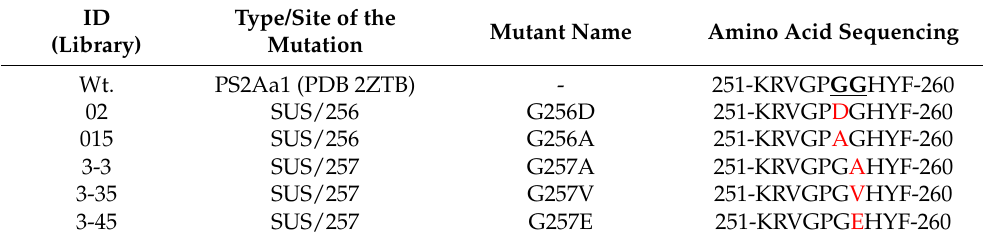
Table 1. Description of parasporins obtained from PS2Aa1 using site-directed mutagenesis. ID Type/Site of the Mutant (Library) Mutation